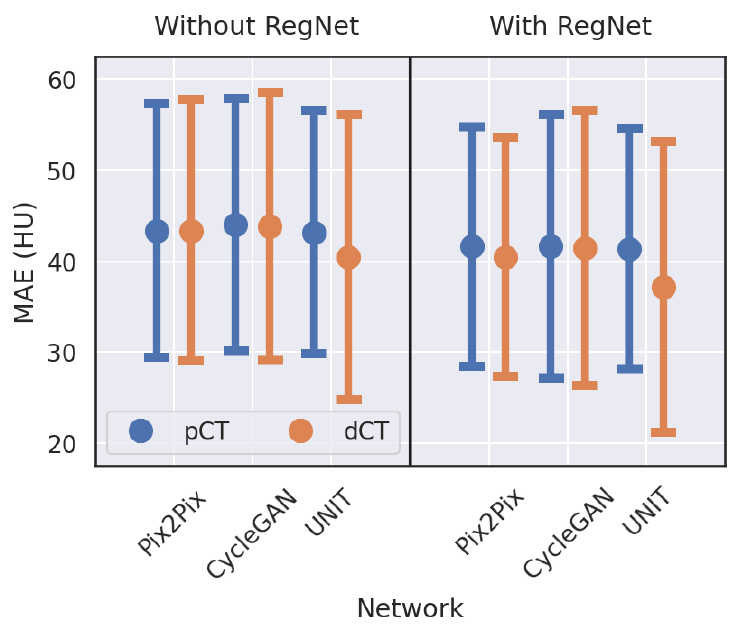
Figure 6. MAEs of sCT generated from different models compared to pCT and dCT. UNIT with RegNet generated sCT with the lowest mean